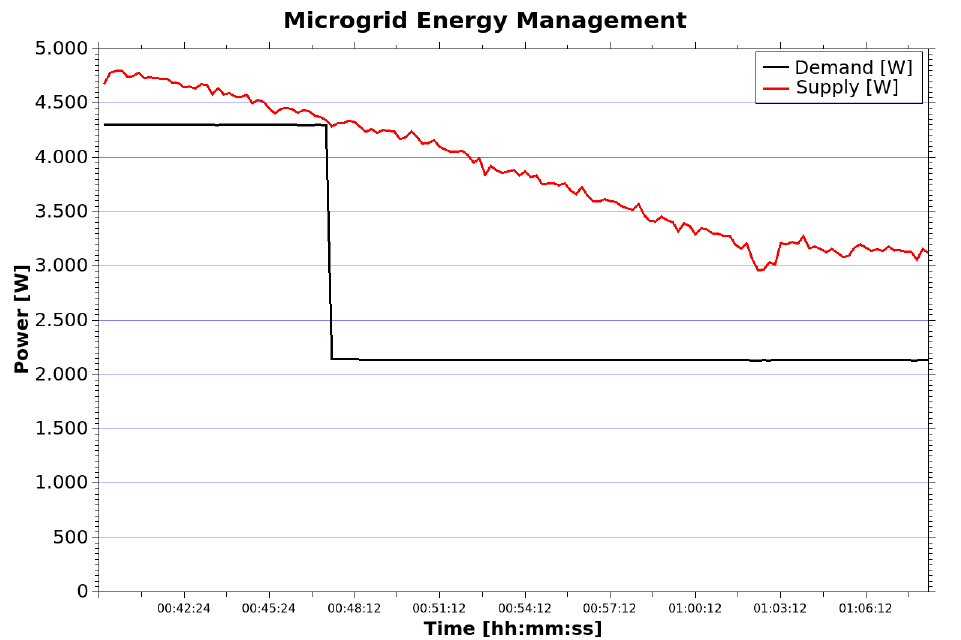
Figure 11. Energy Management for Power Profile